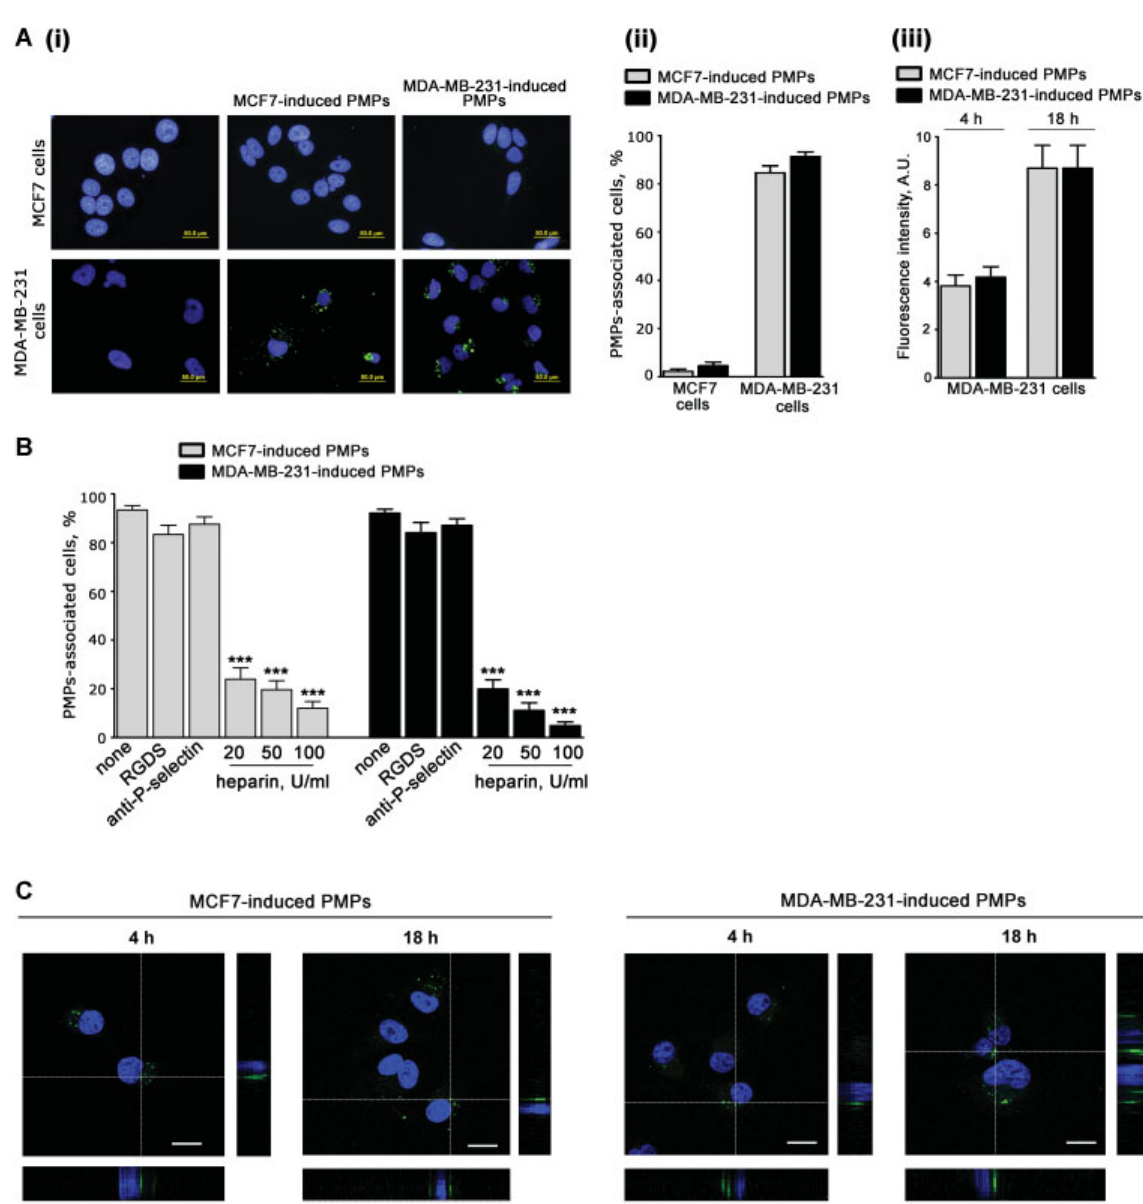
Fig. 2 Interaction of breast cancer cells with platelet-derived microparticles (PMPs). ( A ) MCF7 and MDA-MB-231 cells (5 (cid:3) 10 4 cells/well) were grown on glass coverslips and then incubated with 30 µg/mL of MCF7-induced or MDA-MB-231-induced PMPs obtained from carboxy fl uorescein succinimidyl ester (CFSE)-labeledplatelets (green) for4 or18 hours.(i)Representative fl uorescence microscopy imagesupon 18hours ofincubation.Cellnucleiwere stained with1µg/mLofHoechst(blue);(ii)quanti fi cationofthepercentageofMCF7orMDA-MB-231cells(asindicatedonthebottom)associatedwith fl uorescent PMPs, induced by either MCF7- or MDA-MB-231 cells (gray and black bars, respectively, as indicated on the top). Data are the mean (cid:4) SEM of three independent experiments. (iii) Comparison of MDA-MB-231 cells ’ ability to interact with MCF7- or MDA-MB-231-induced PMPs after 4 or 18 hours of incubation. Data are expressed as average green fl uorescence intensity associated with each cell and are the mean (cid:4) SEM of three independent experiments. ( B ) MDA-MB-231 cells were incubated with MDA-MB-231- or MCF7-induced PMPs obtained from CFSE-labeled platelets (30 μ g/mL) in the presenceofbuffer(none),0.5 mMRGDS,10 μ g/mLanti-P-selectinantibodyCLB/thromb/6,orincreasingamountofheparin,asindicated.Thepercentageof PMPs-associatedcellswasdeterminedasdescribedinpanelA,andresultsareexpressedthemean (cid:4) SEMofthreeindependentexperiments( (cid:1)(cid:1)(cid:1) p < 0.001). ( C ) Confocal microscopy analysis of MDA-MB-231 cells interacting with MCF7- or MDA-MB-321-induced PMPs for the indicated times of incubation. Representative confocal middle z-sections and orthogonal views are reported. Scale bars: 20